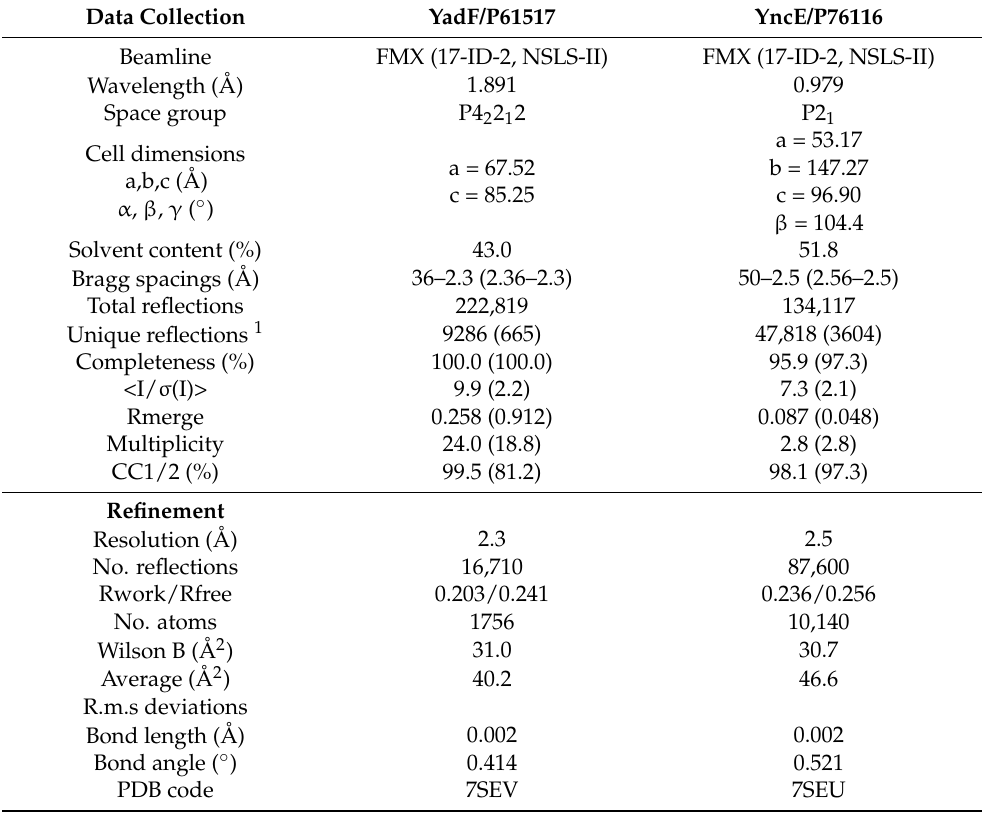
Table 1. Data collection and refinement